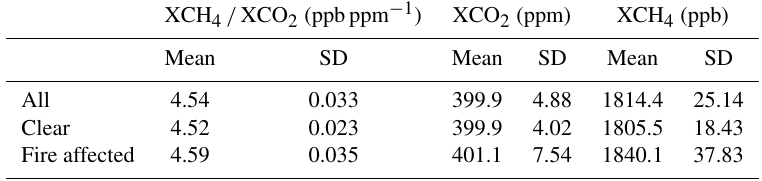
Table 1. Table showing the mean and standard deviation over Indonesia in September–October 2015 of the XCH 4 / XCO 2 ratio (left), the retrieved XCO 2 (centre) and the retrieved XCH 4 (right) for all data, data determined to be unaffected by fire and data determined to be affected by